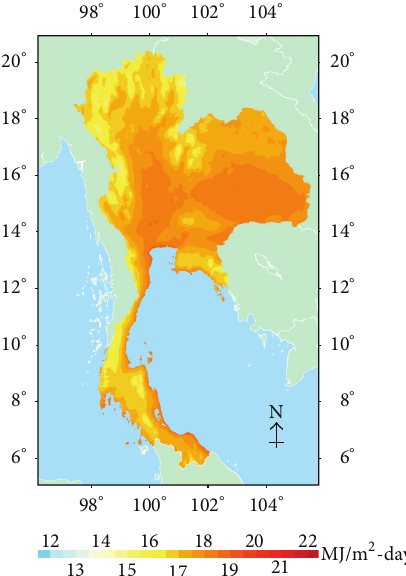
Figure 5: Yearly average of daily global radiation over